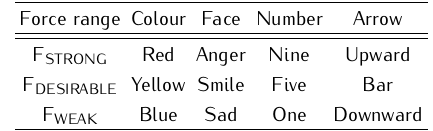
Figure 4. An example of the colour changing algorithm.